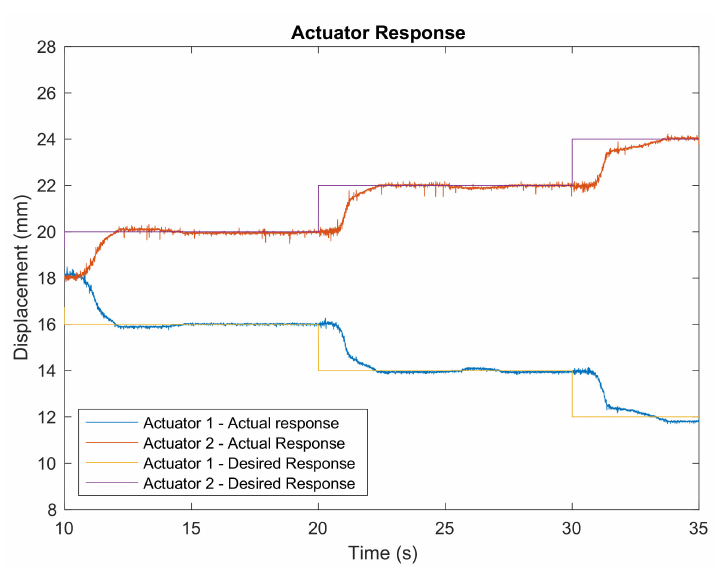
Figure 5. The actual and desired responses of Actuator 1 and Actuator 2.